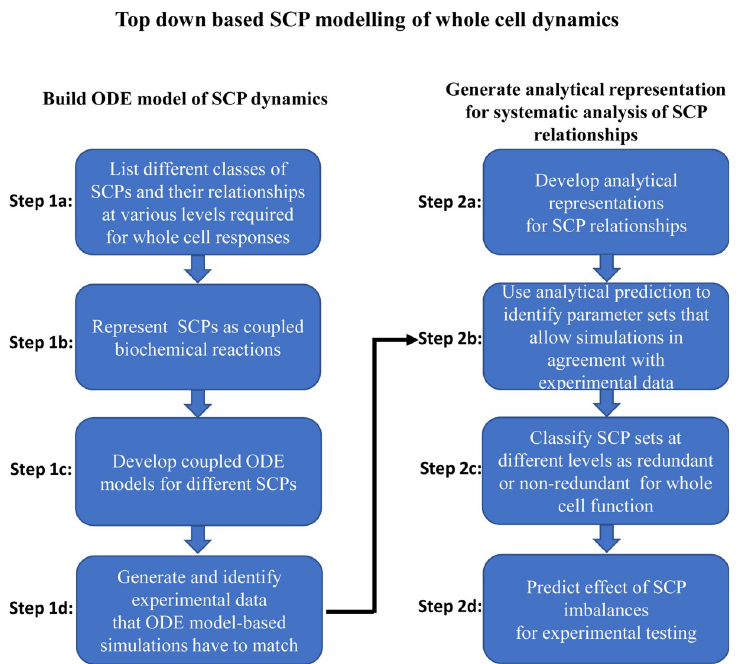
Fig 2. Top-down based SCP modelling of whole cell dynamics. Our pipeline for the generation of dynamical models that allow the analysis of relationships between sub-cellular processes (SCPs) during whole cell responses consists of two major steps. First, we build multicompartmental ODE models for the simulation of SCP activities that are based on literature curated data (Step 1a-d). In the second step we develop analytical predictions for kinetic parameters at steady state that allow a systematic analysis of SCP interactions (Step